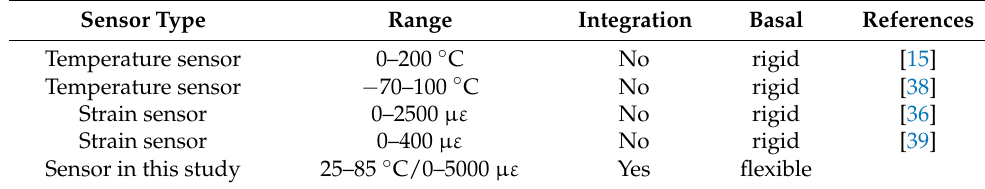
Table 1. Comparison between the sensors we studied and previously reported sensors. Sensor